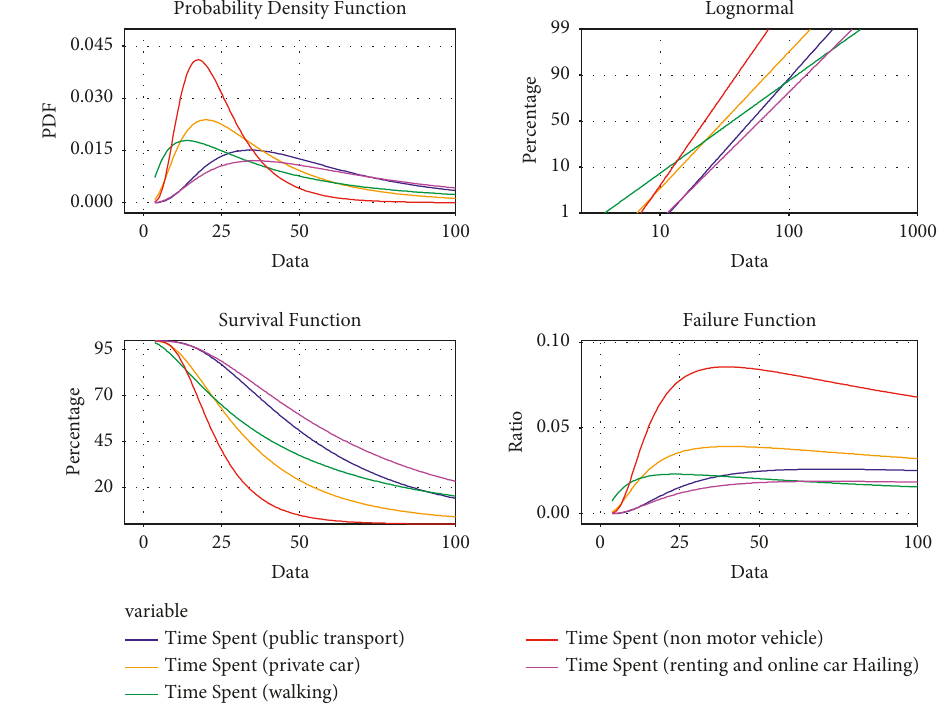
Figure 5: The distribution fitting of the travel mode. Table 6: Different distributions’ goodness of fit for the same model.